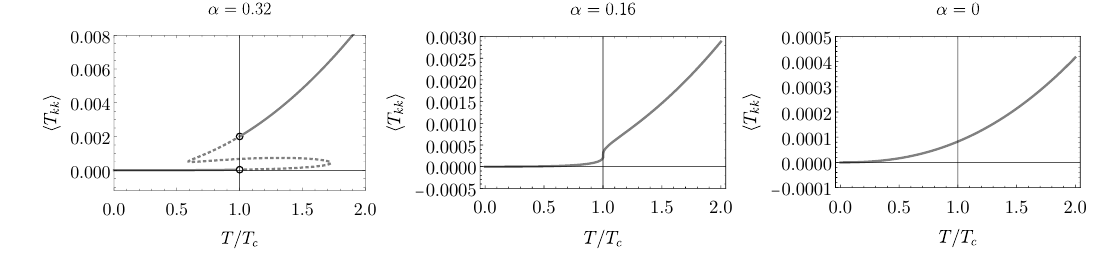
Figure 14 . h T kk i as function of temperature for different values of α